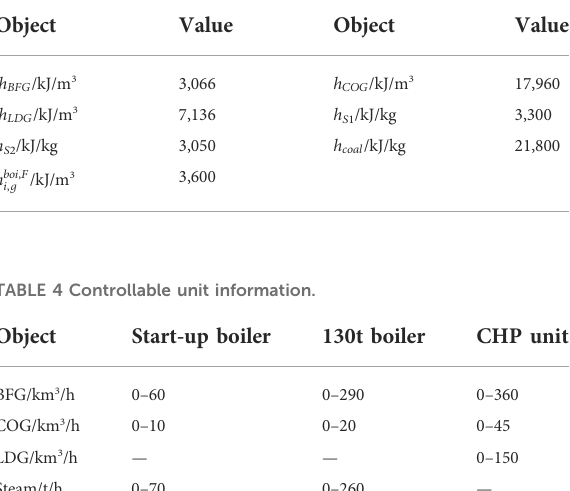
TABLE 3 Fuel-steam heat (enthalpy) value information.